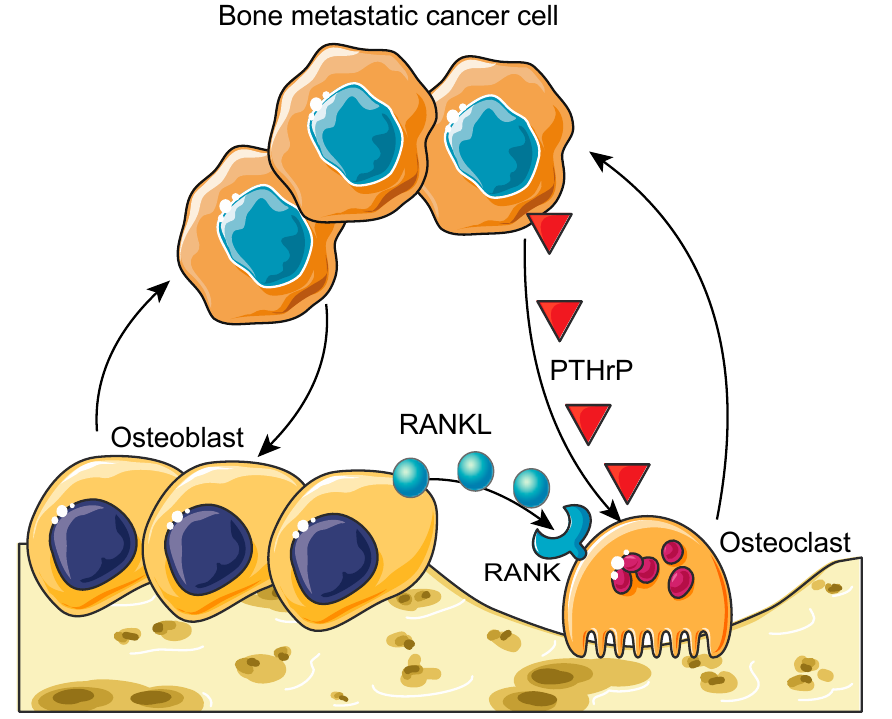
Figure 1. The vicious cycle of bone metastases. Bone metastatic cancer cells hijack the healthy bone remodeling process to create a suitable microenvironment for them to grow. Cancer cells induce hyper-osteoclastogenesis by activating osteoclasts through the secretion of parathyroid-hormone- related peptide (PTHrP). This process leads to osteolytic bone lesions and provides bone metastatic cancer cells more space to grow. On the other hand, cancer cells can over-activate osteoblasts, resulting in osteoblastic bone lesions. These hyper-activated osteoblasts also stimulate osteoclastogenesis through the receptor activator of the nuclear factor κ B ligand (RANKL) (secreted from osteoblasts)/RANK (expressed on osteoclasts) axis. Furthermore, these hyper-activated osteoblasts and osteoclasts enhance the growth and survival of bone metastatic cancer cells. This process is called the vicious cycle of bone metastasis. Graphics adapted from Smart Servier Medical Art (https://smart.servier.com/, accessed on 18 March 2021).